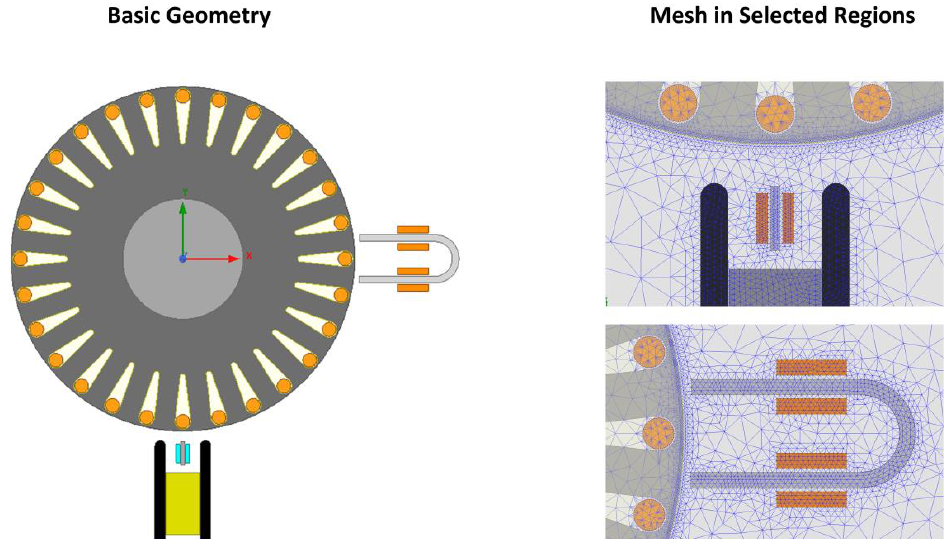
Figure 4. 2D FEM model of the test rotor assembly with mesh in the sensor regions.